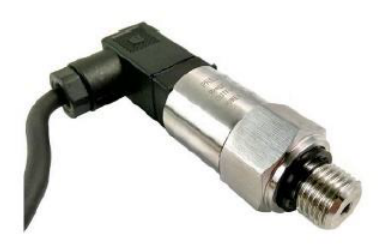
Figure 5. Pressure transducer.